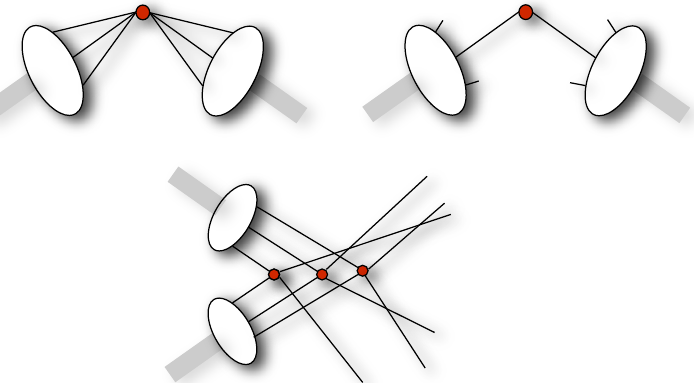
Figure 3. Real space pictures associated with different momentum-space integration regions of models of exclusive processes. Top Left: A short-distance model effectively has participating quarks meeting at a hard scattering (red dots) with points separated spatially by order 1/ Q . Top Right: An endpoint model has a single hard scattering. Low momentum quark spectators transfer from one struck hadron to another. Since finding soft, non-participating quarks is rare in proportion to how many are soft, this process happens to have the same “quark counting” rules as a short-distance model. Bottom : A Landshoff process treats quarks acting completely independently, and flying off at random. The coincidence of final state quarks accidentally traveling parallel to form a final state hadron is calculated from a phase space